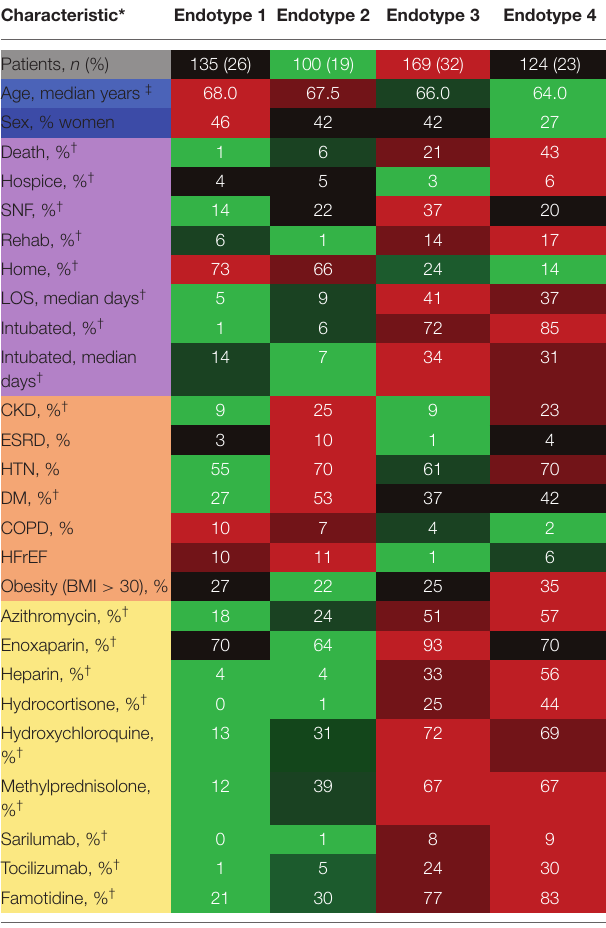
* Characteristics are only shown if p < 0.05 indicating that values of the four groups are significantly different. Values are color-coded by characteristic from red (high) to black (median) to green (low). Number of patients included for reference, but no statistical test was run. † Denotes p < 0.001. ‡ Ageincludedforreferenceinthistablebutwasafeatureusedinclusteringandp > 0.05. reviewed medications at similar rates as patients in endotype 4 (except for enoxaparin, heparin, and hydrocortisone). Endotype 4 patients had a median age of 64 years, included the fewest women (27%), greatest degree of mortality (43%), a fairly long hospital length-of-stay (median 37 days), and were the most intubated (85%). This endotype had moderate amounts of CKD and ESRD, higher amounts of HTN, and the most obesity. Endotype 4 patients had the highest inflammatory markers (ferritin, LDH were significantly higher than endotype 3 while IL-6 and CRP were similarly high as endotype 3), highest infectious markers (WBC, procalcitonin), and greatest degree of coagulopathy (PT and PTT, but PT was not significantly > endotype 3). The exception was ESR which was lower than endotypes 2 and 3. Endotype 4 patients received the most of the reviewed medications (except for enoxaparin and hydroxychloroquine). Of the medications, only hydrocortisone and heparin use were significantly more than in endotype 3.